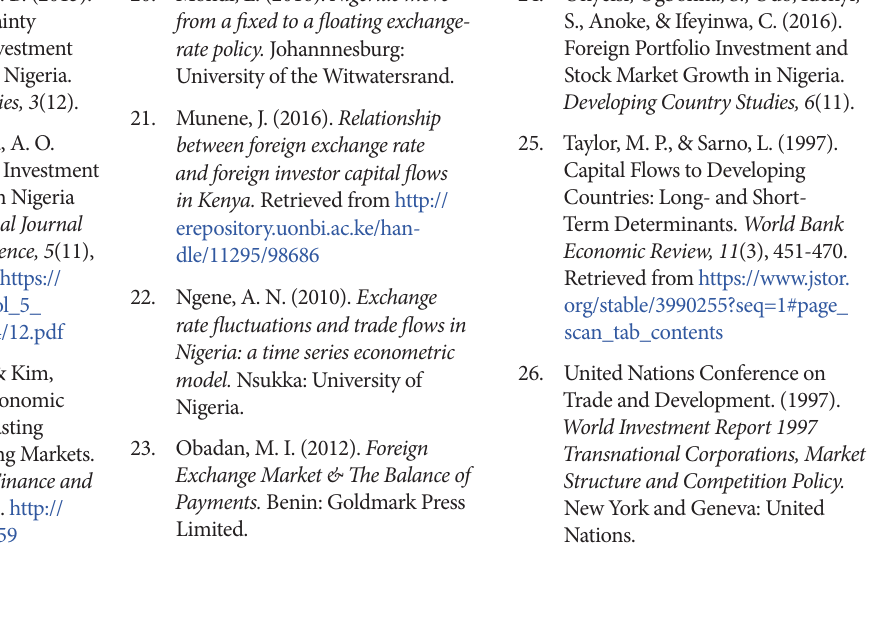
Table A1. Correlation matrix